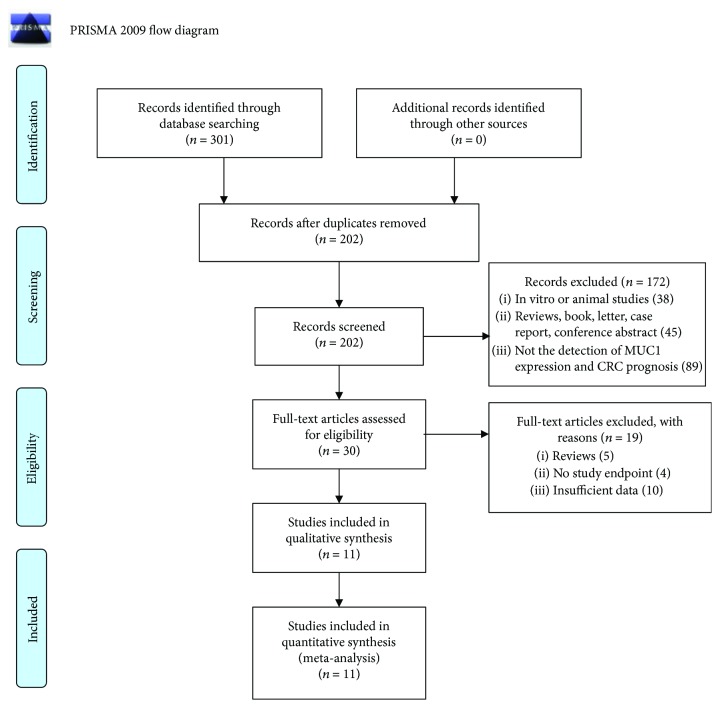
Flow chart of literature search. From: Moher D, Libertati A, Tetzlaff J, Altman DG, The PRISMA Group (2009). Preferred Reporting Items for Systematic Reviews and Meta-Analyses: The PRISMA Statement. PloS Med 6(7): e1000097. doi:10.1371/journal.pmed1000097. For more information, visit http://www.prisma-statement.org.